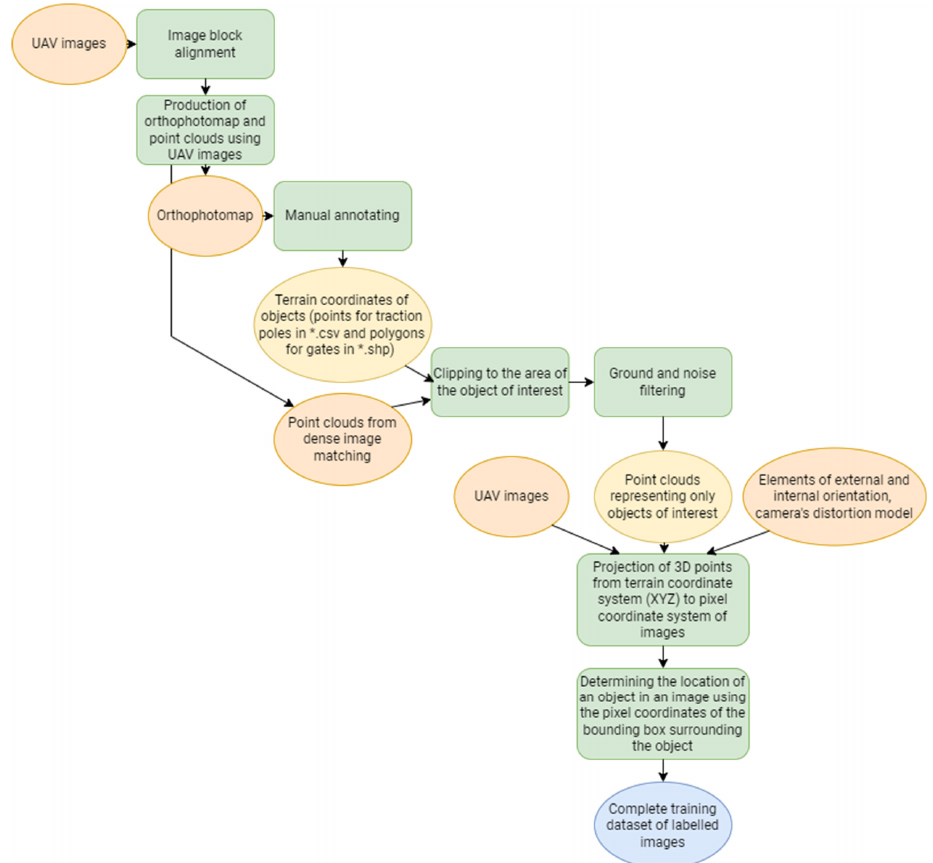
Figure 9. Workflow to semi-automate the process of preparing training datasets for object detection.